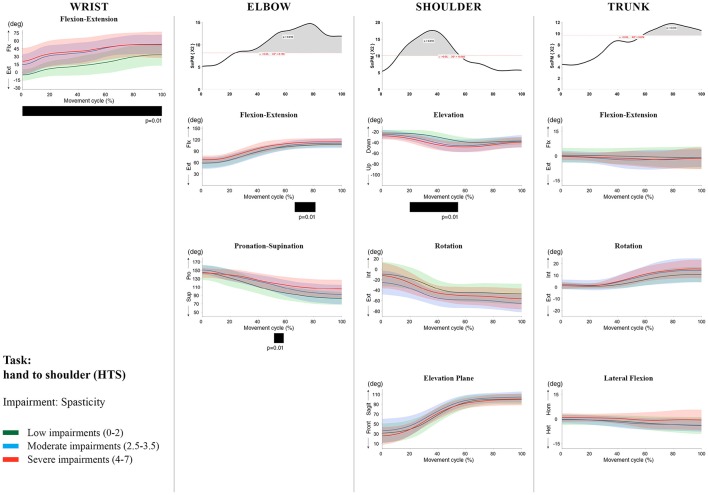
Impact of spasticity on UL movement patterns in children with uCP during the HTS task for all joint angles. Each column corresponds to a joint (from left to right: wrist, elbow, shoulder, and trunk). The top image of each column is the SPM output of the vector field analysis (non-parametric Canonical Correlation Analysis test, except for the wrist, where a non-parametric linear regression was computed). For visualization purposes, kinematic data was grouped according to the level of motor impairments, i.e., spasticity total score: low impairments (score between 0 and 2, i.e., values above percentile 75), moderate impairments (score between 2.5 and 3.5, i.e., values between percentile 25 and 75), and severe impairments (score between 4 and 7, i.e., values below percentile 25). Below, mean (bold line) and standard deviation (translucent area) of the low impairments (green), moderate impairments (blue), and severe impairments (red) of each vector component and the respective post-hoc SPM{t} output. The black bar under each kinematic profile indicates clusters of significant influence of the impairment level on the kinematic variable.